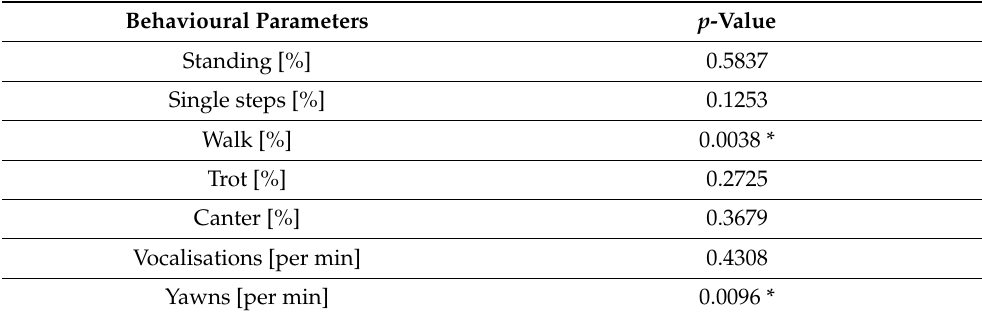
Table 4. The influence of experimental conditions on behavioural parameters: Friedman test prob- ability value.